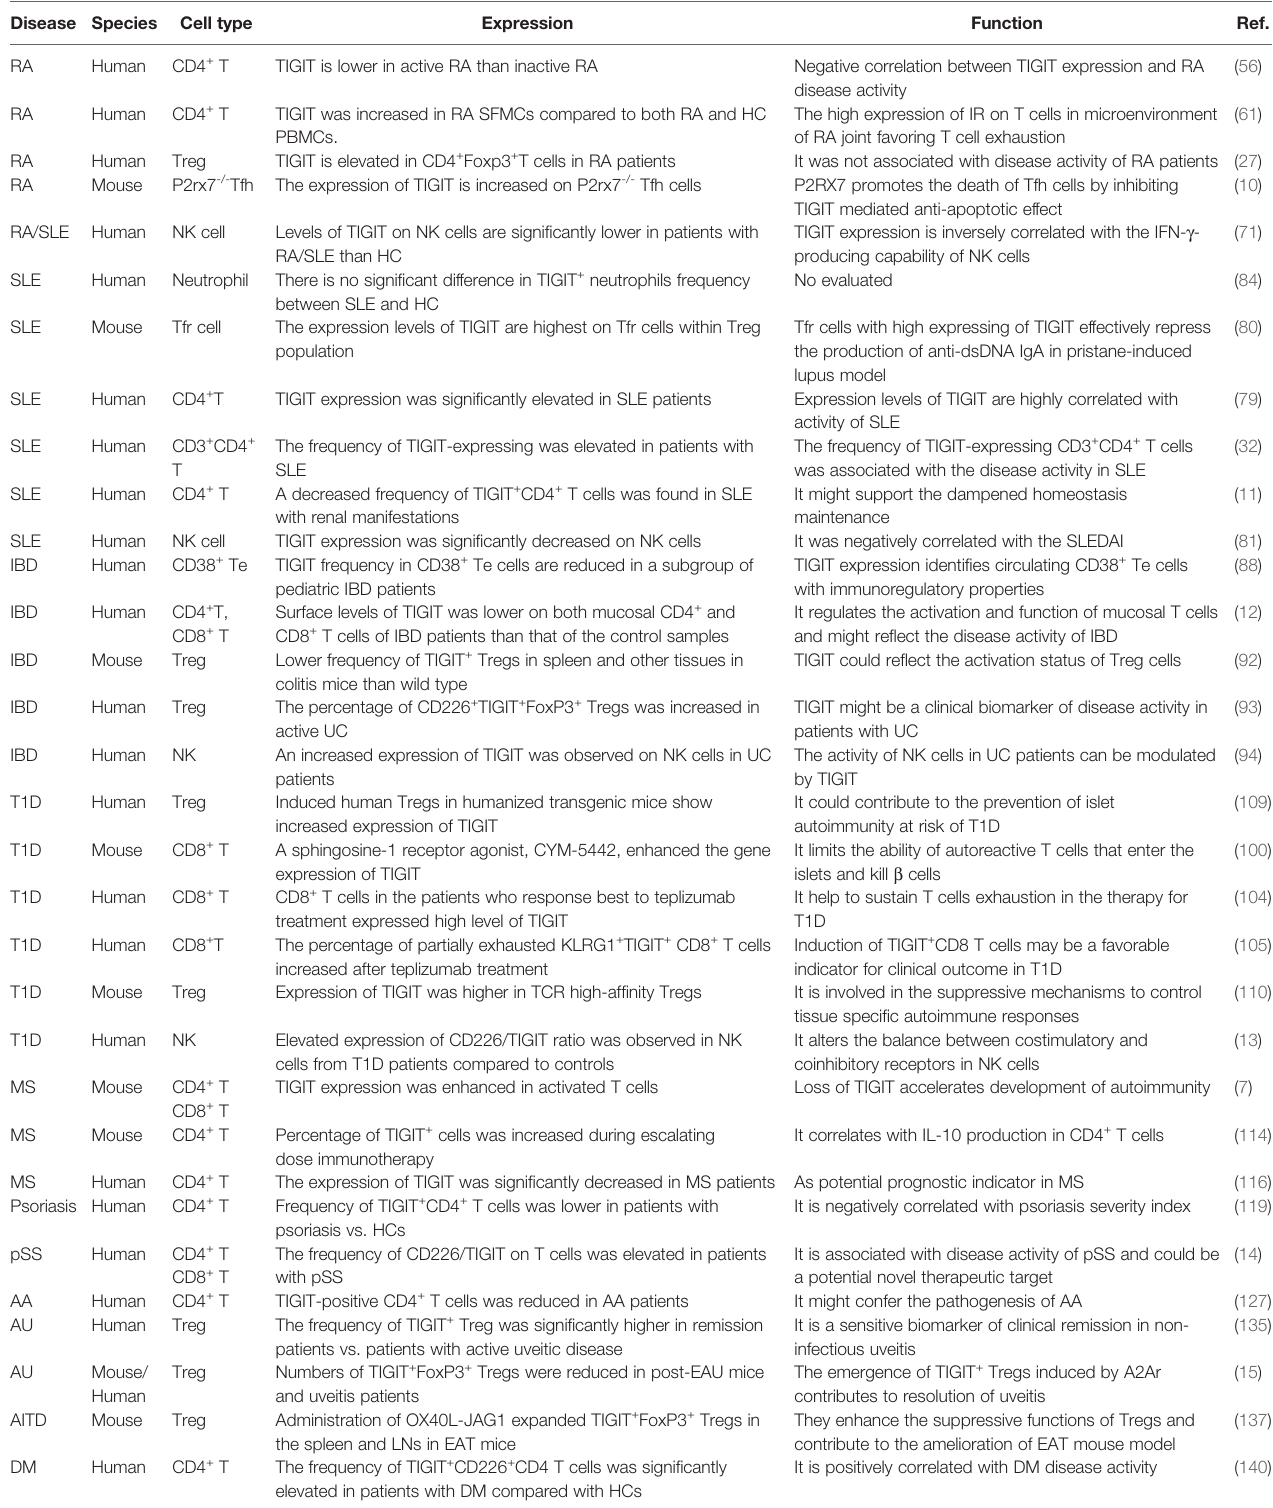
TABLE 1 | Expression pro fi le and potential roles of TIGIT in autoimmune diseases. Disease Species Cell